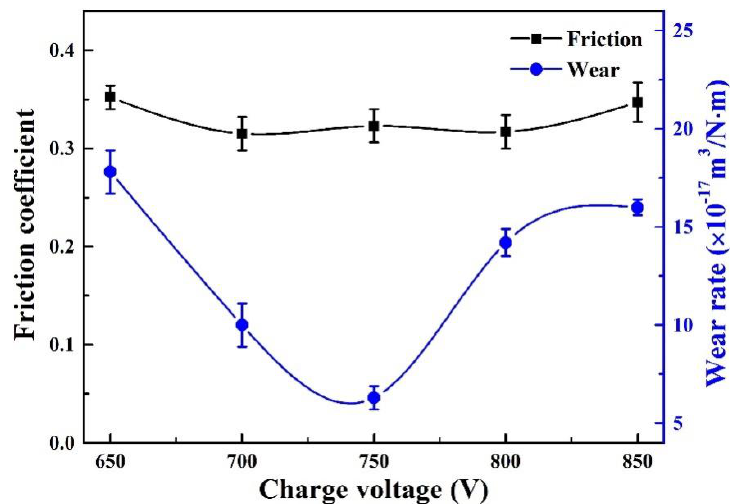
Figure 10. Friction coefficient and wear rate of Mo–Cu–V–N coatings as a function of charge volt- age.